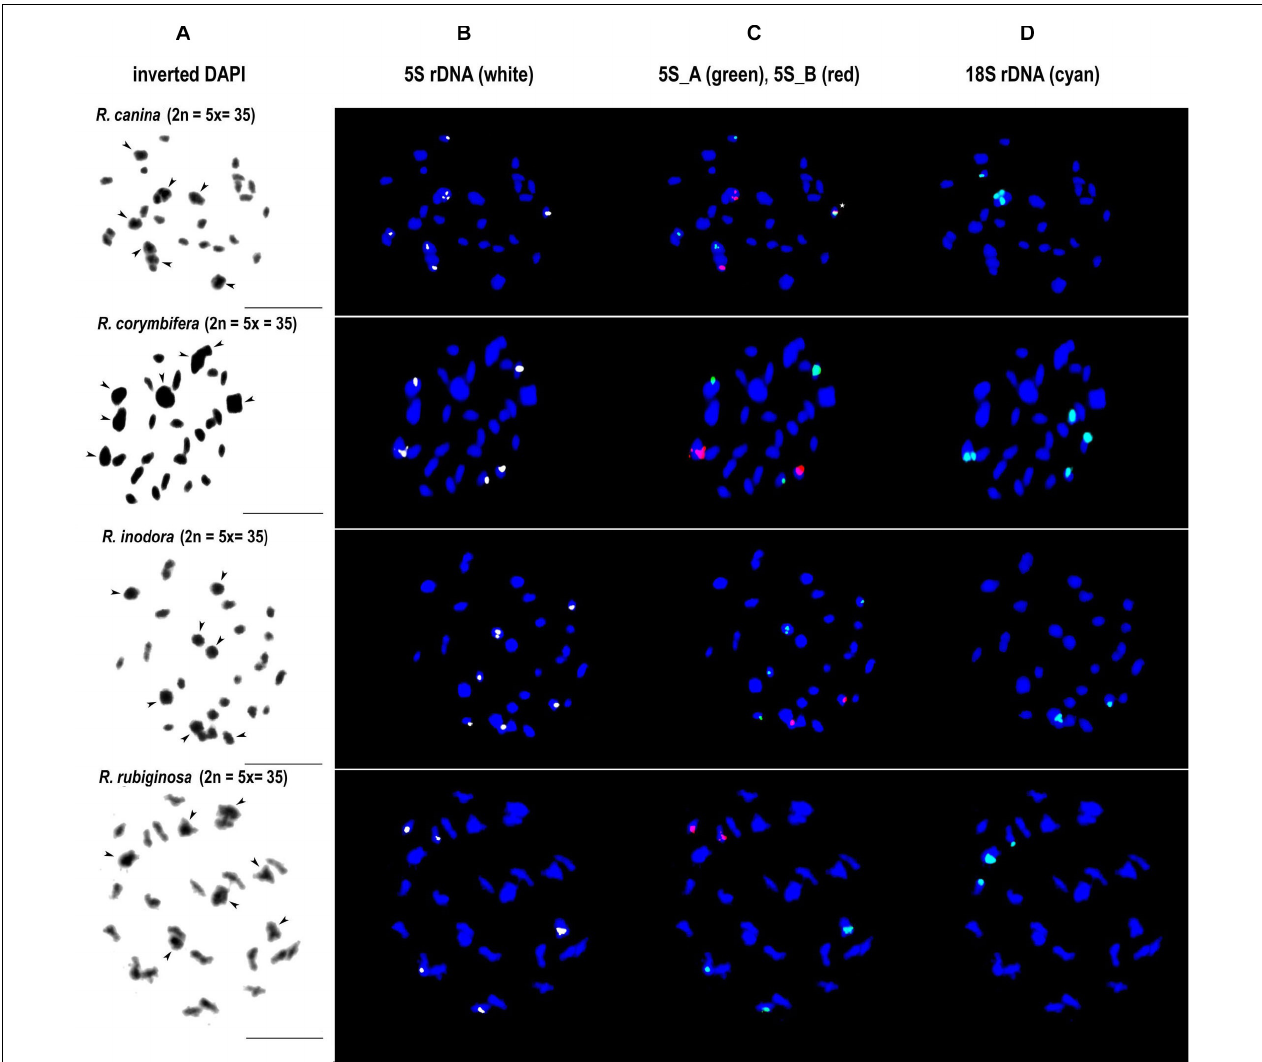
FIGURE 7 | FISH analysis of meiotic chromosomes in pentaploid dogroses section Caninae : R. canina and R. corymbifera (subsection Caninae ); R. inodora and R. rubiginosa (subsection Rubigineae ). In each species, the same diakinesis was hybridized with the 5S genic (B) , 5S intergenic (C) , and 18S rDNA (D) probes. DAPI staining (gray scale, inverted) is to the left margin (A) . Arrowheads indicate bivalent chromosomes. In R. canina , a chromosome with co-localized 5S_A and 5S_B signals is marked with an asterisk. Scale bar: 10 µ